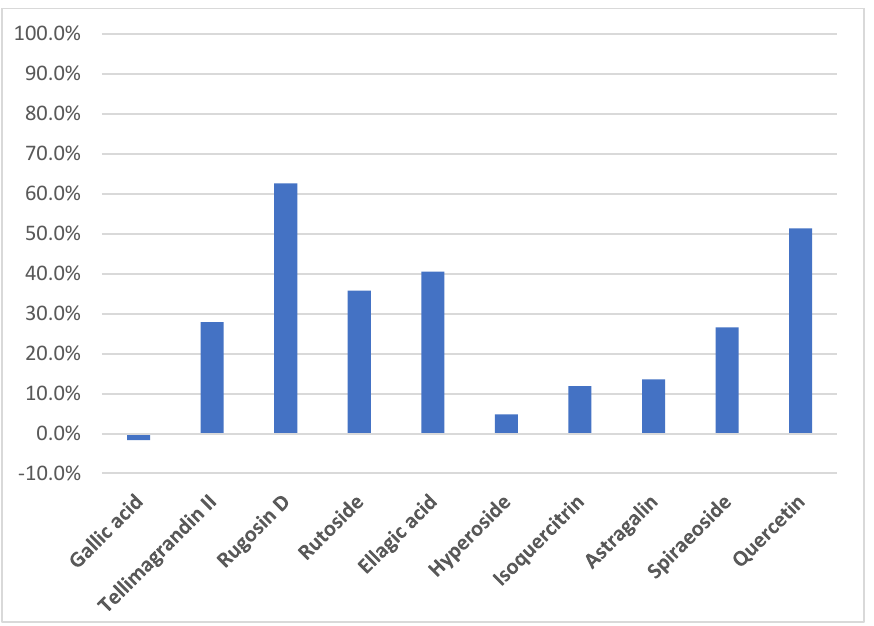
Figure 5. Evaluation of XO binding (%) performed by HPLC analyses .